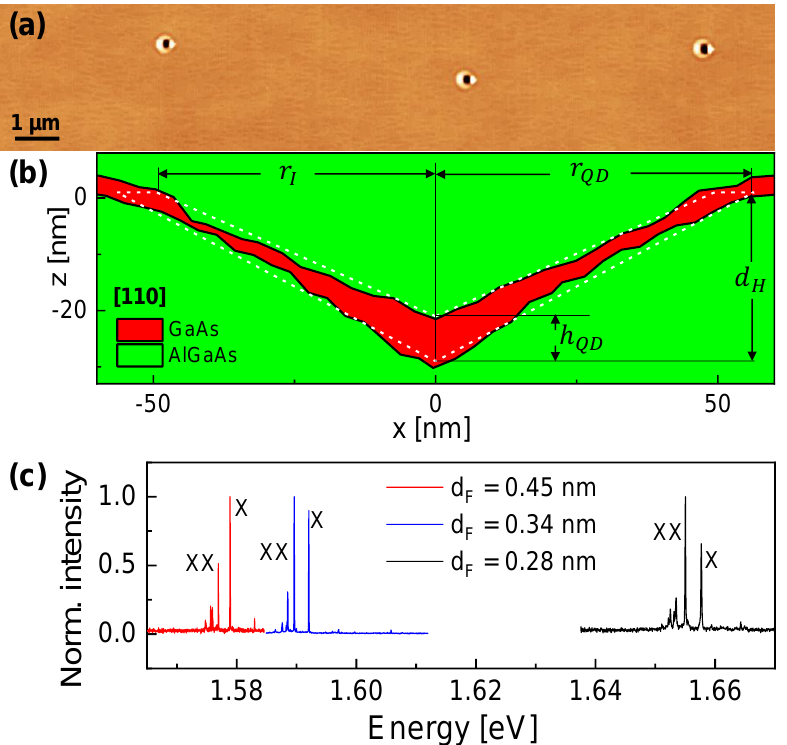
Figure 1. ( a ) Top-view atomic force microscopy (AFM) image of an AlGaAs surface after local droplet etching with Al. The low-density nanoholes are clearly visible. ( b ) AFM line scans along the [110] direction to illustrate the cross-section of a GaAs cone-shell QD (red) embedded in an AlGaAs matrix (green). The thickness of the GaAs filling layer is d F = 0.45 nm. The dashed white lines indicate the approximated QD shape used for the simulations, and the four model parameters are indicated. ( c ) Typical PL spectra from single cone-shell GaAs QDs with size varied by nanohole filling with different d F . Exciton X and biexciton XX peaks are